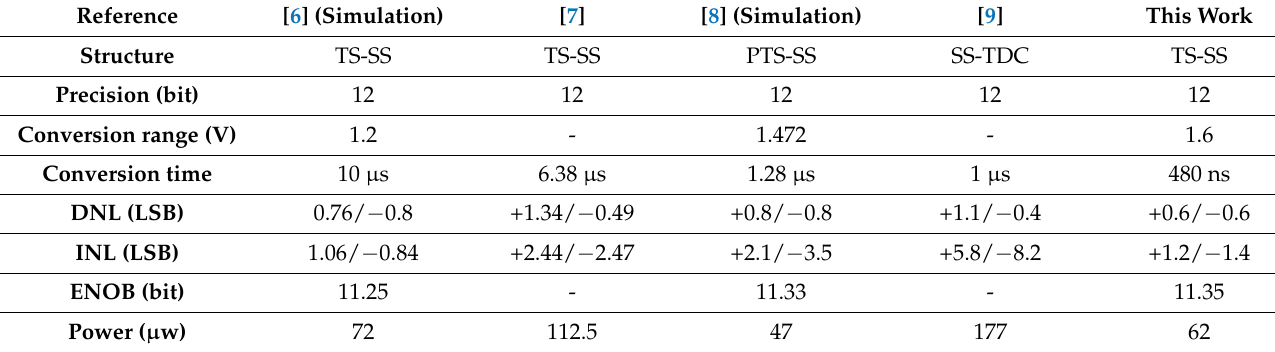
Table 1. Performances compared with state-of-the-art